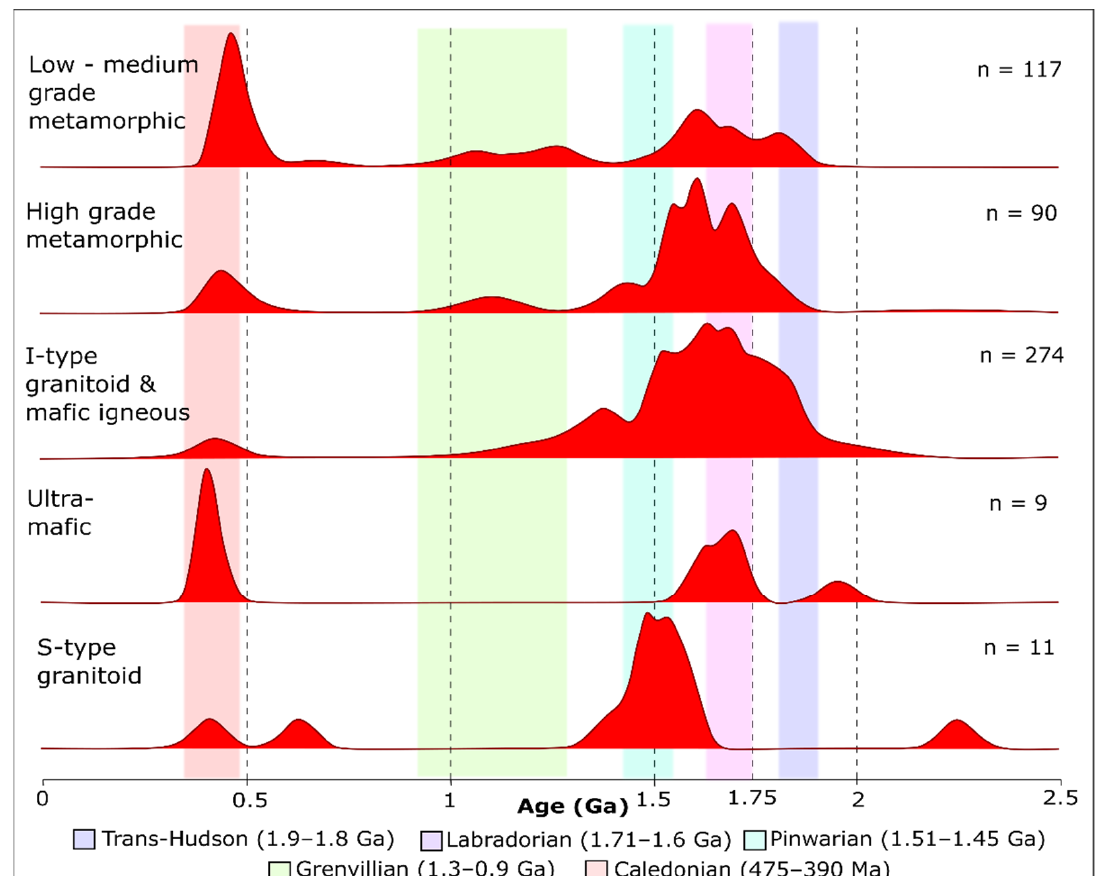
Figure 9. Kernel density estimates of basement terrane lithology from trace elements in apatite plotted against age. All samples from the five channel sandstone units in the Mullaghmore Sandstone Formation at Ballycastle are plotted together. Major orogenic events highlighted in vertical colour bands. Bin size is 30 Ma.